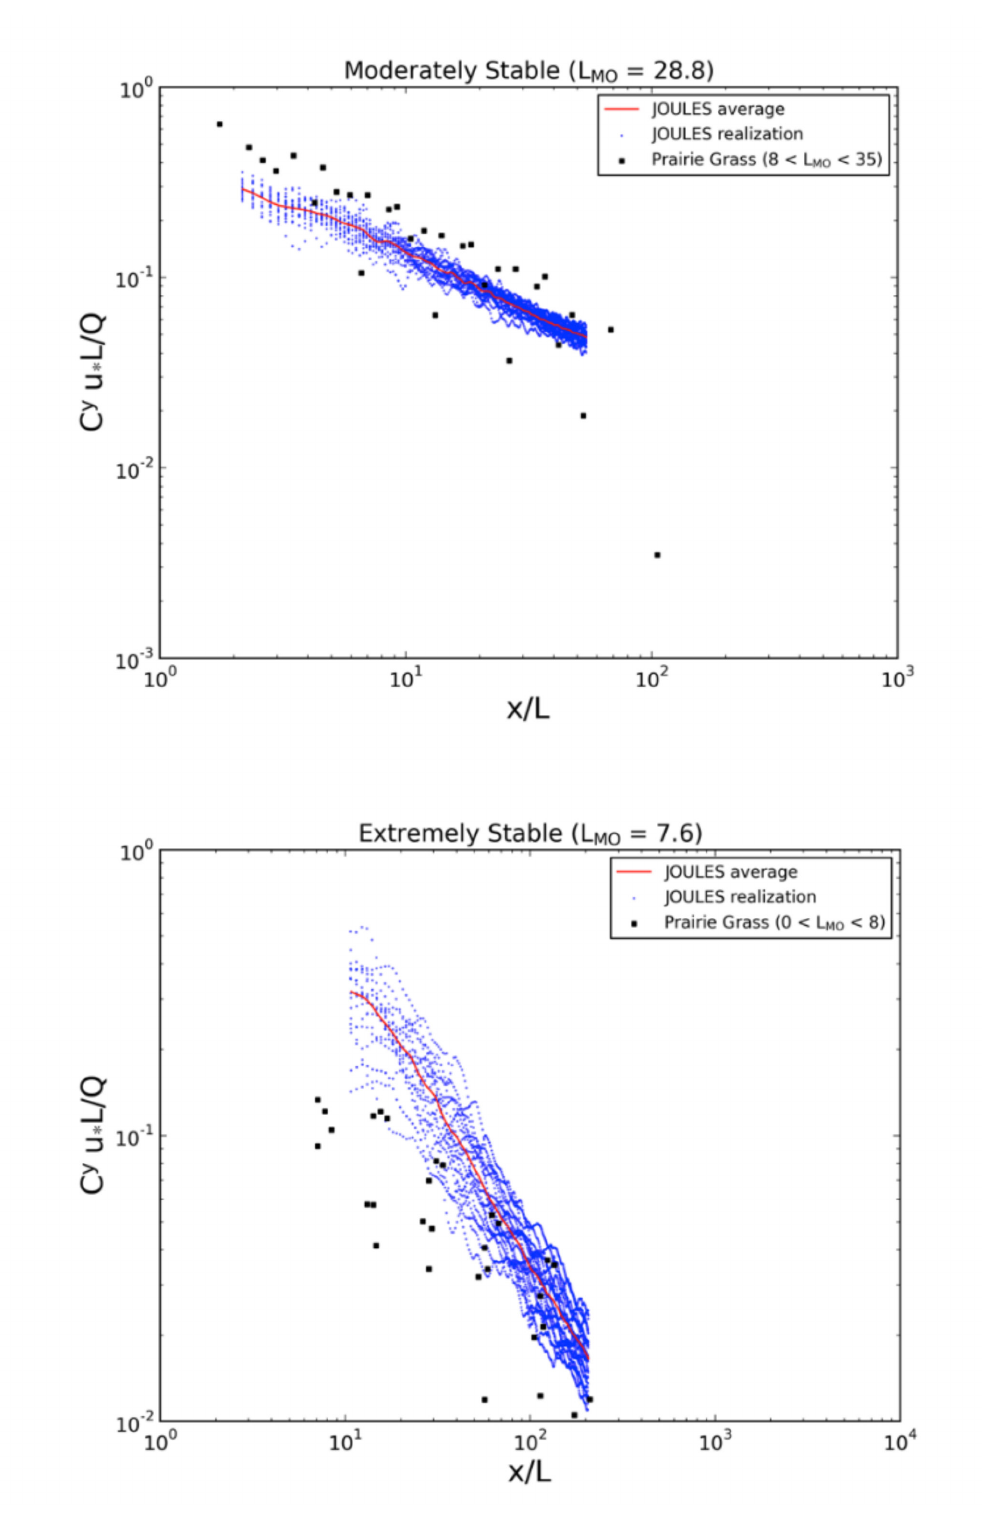
Figure 13. Normalized crosswind integrated concentration as a function of downwind distance from the release location, for weakly ( top ), moderately ( middle ), and extremely ( bottom ) stable conditions. The black square markers are derived from the Prairie Grass experiments. Blue dots represent individual realizations of dispersion from the GPU-LES model. The red line represents the average of this ensemble of simulated